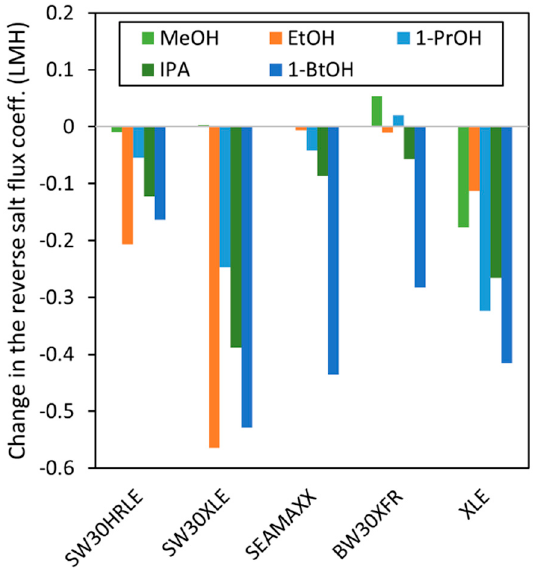
Figure 6. Change in the salt reverse flux coefficient (B f –B 0 ) (calculated using Equation (15)) for each membrane after contact with different alcohols.